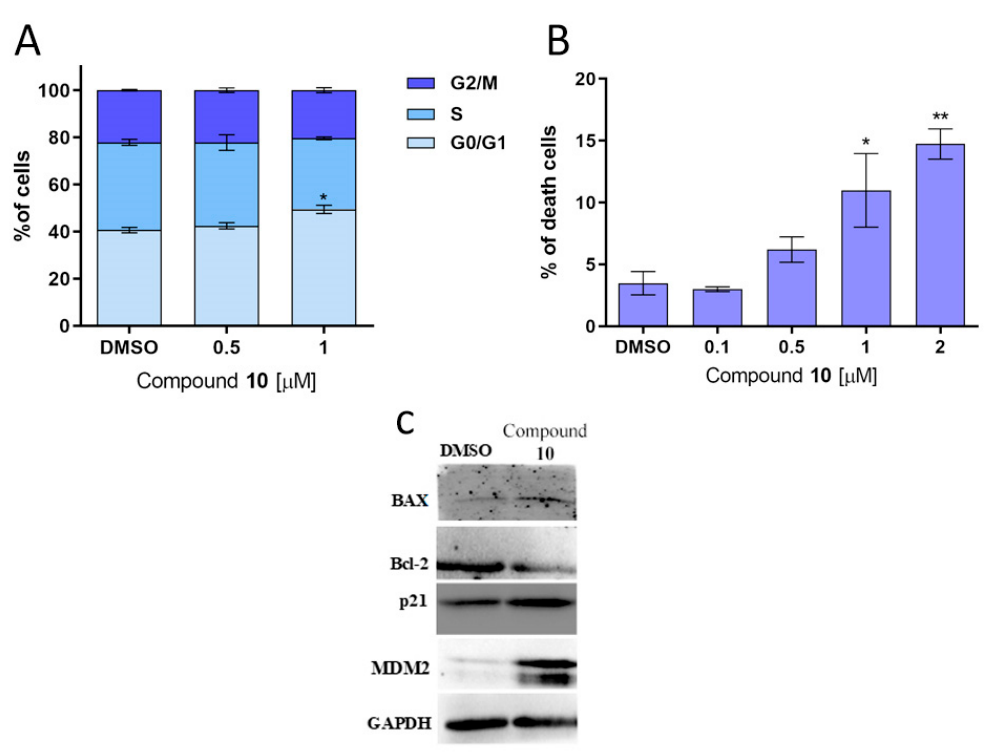
Figure 3. Norhierridin B ( 10 ) induces cell cycle arrest and death and interferes with p53 transcriptional targets. (A ) Cell cycle progression was analyzed after 48 h treatment with compound 10 in MDA-MB-231 cells; data are mean ± SEM of three independent experiments; values significantly di ff erent from DMSO: * p < 0.05, unpaired Student’s t -test. (B ) Percentage of death cells determined by trypan blue assay for MDA-MB-231 cells treated with compound 10 for 48 h; data are mean ± SEM of three independent experiments; values significantly di ff erent from DMSO: * p < 0.05, ** p < 0.001, unpaired Student’s t -test. (C ) Protein expression levels of p53 targets in MDA-MB-231 cells was analyzed by western blot after 48 h treatment with 2 µ M compound 10 . Immunoblots are representative of three independent experiments; GAPDH was used as loading control.